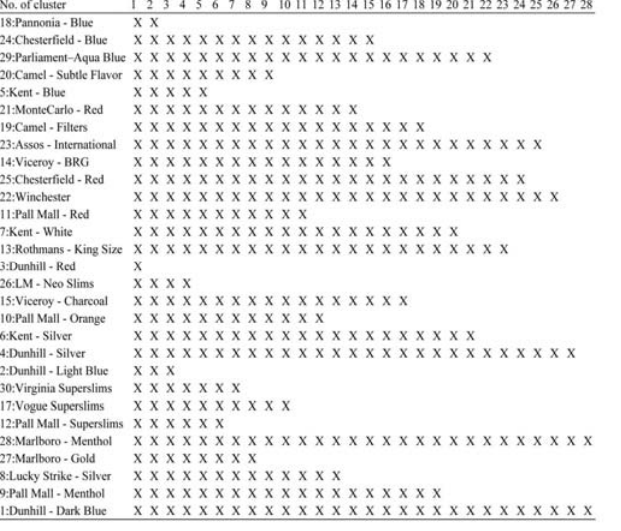
Figure 1: Horizontal icicle plot